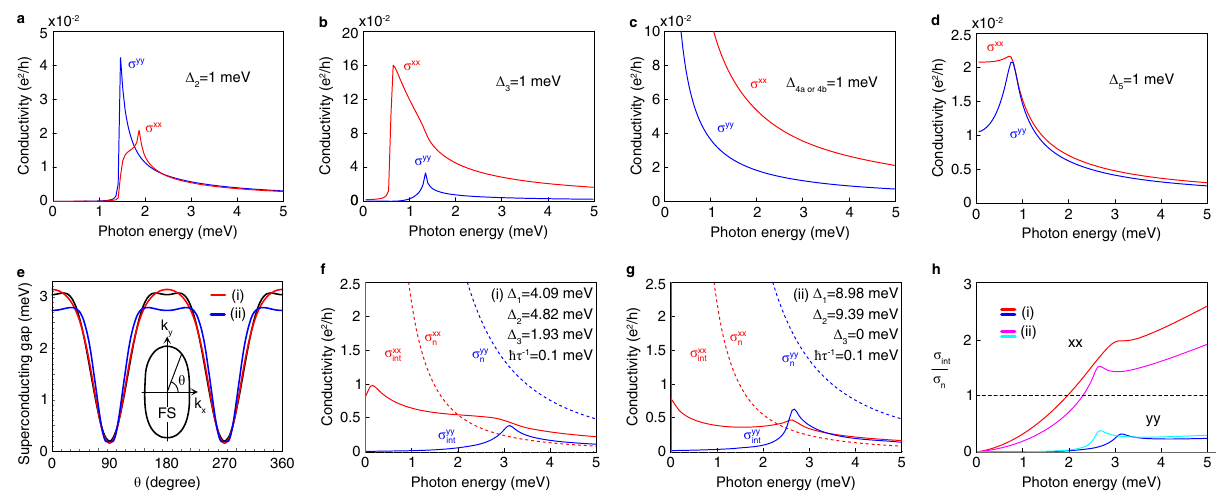
Fig. 3 Optical conductivity in a model of superconducting FeSe near Γ at zero temperature. Model parameters in the normal state are adapted from ref. 39 (see section 6 in the Methods). The xx and yy components of the conductivity tensor is shown in red and blue, respectively, in ( a – d , f , g ). a – d Nonzero intrinsic optical conductivity tensors for each constant pairing function. See Methods and Table 2 for the matrix form and symmetries of the six constant pairing functions Δ 1 – Δ 4 a , Δ 4 b , and Δ 5 . The case of the Δ 1 pairing is not shown as the conductivity is identically zero. e Superconducting gap similar to the experimentally observed gap. FS and the ellipse enclosing it represent the Fermi surface. Red and blue curves correspond to the choice of pairing functions (i) Δ 1 = 4.09 meV, Δ 2 = 4.82 meV, and Δ 3 = 1.93 meV or (ii) Δ 1 = 8.98 meV, Δ 2 = 9.39 meV, and Δ 3 = 0 meV, respectively. They are least- square fi ts with and without Δ 3 to Δ ð θ Þ ¼ j 2 : 06 þ 1 : 42cos ð 2 θ Þ (cid:2) 0 : 44cos ð 4 θ Þj (shown as a black curve) that was obtained in ref. 15 from experimental data. f , g Conductivity with pairing functions used in ( e ). σ int is the internal optical conductivity in the superconducting state (solid lines), and σ n is the Drude conductivity in the normal state (dashed lines). The disorder-mediated conductivity in the superconducting state is expected to be comparable to σ n . h Ratio of σ int and σ n . Red and blue curves are for parameters in ( f ), and magenta and cyan are for parameters in ( g ). xx and yy indicate the component of the conductivity tensor. σ xy and σ yx are not shown in all plots because they vanish due to M x